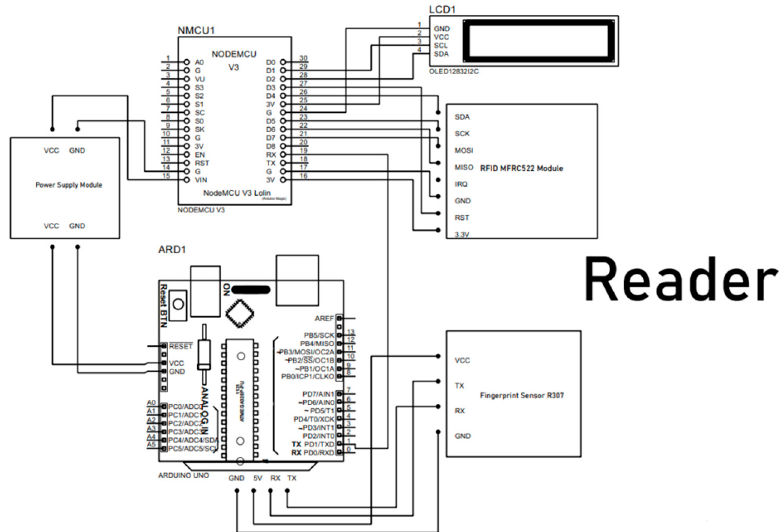
Figure A2. Circuit diagram of the RFID reader .